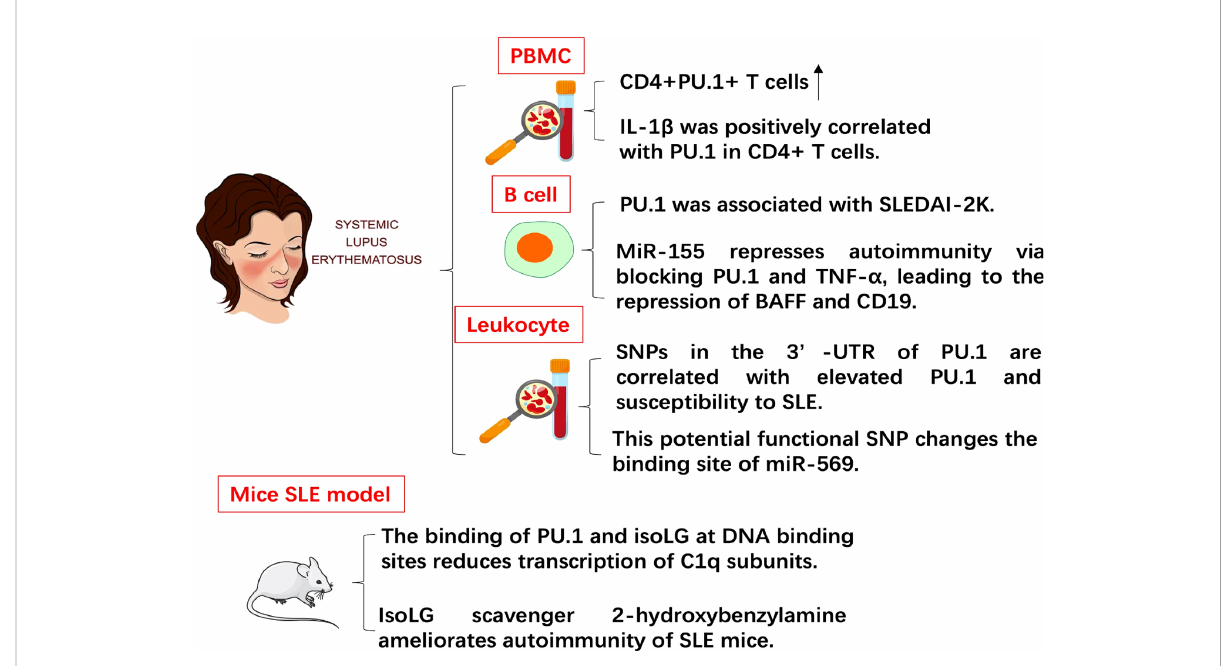
FIGURE 3 The role of PU.1 in SLE. The expression of PU.1 is positively correlated with IL-1 in CD4+ T cells from patients with SLE. PU.1 is also positively associated with SLE disease activity index 2 K (SLEDAI-2K). SNP (rs1057233) in the 3 ’ -UTR of PU.1 is correlated with elevated PU.1 and susceptibility to SLE. In mouse SLE model, the binding of PU.1 and isoLG at DNA binding sites reduces transcription of C1q subunits. IsoLG scavenger ameliorates autoimmunity of SLE